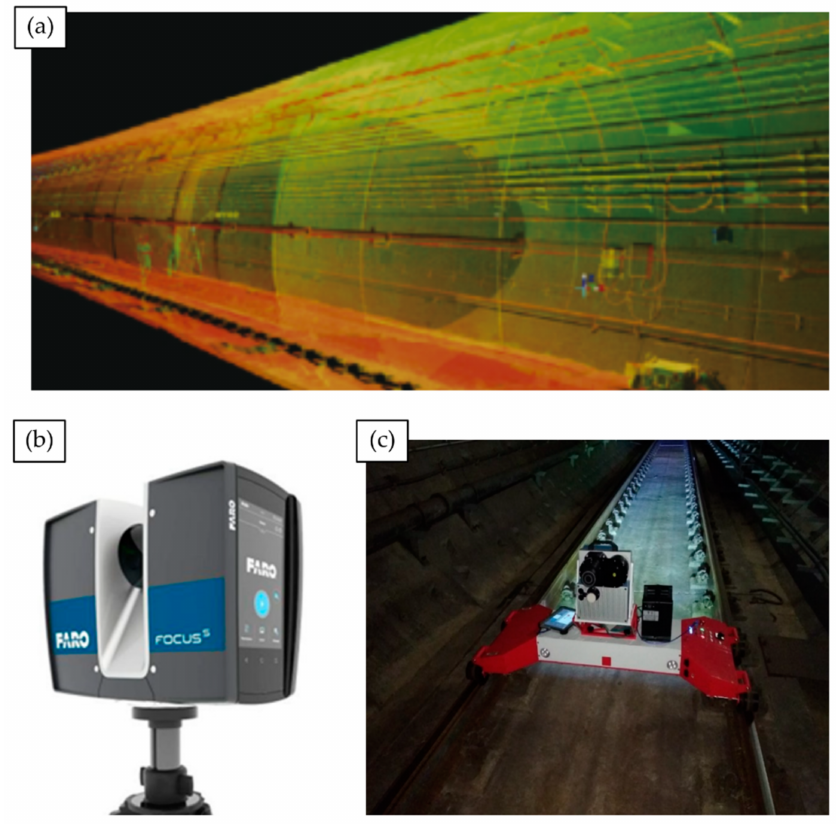
Figure 2. TLS for tunnel inspection. ( a ) 3D point cloud returned from a TLS metro tunnel sur- vey [52]; ( b ) A FARO ® FOCUS 350 scanning module, commonly deployed for infrastructure surveys; ( c ) TMMS rail-trolley transports a Z+F9012 to capture a TLS point cloud of a Zhengzhou metro